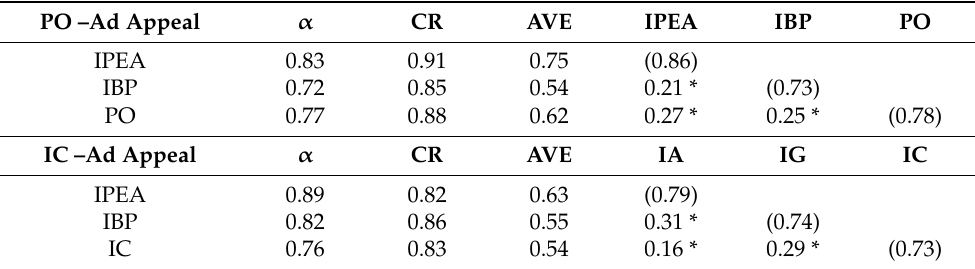
Table 5. Discriminant and Convergent